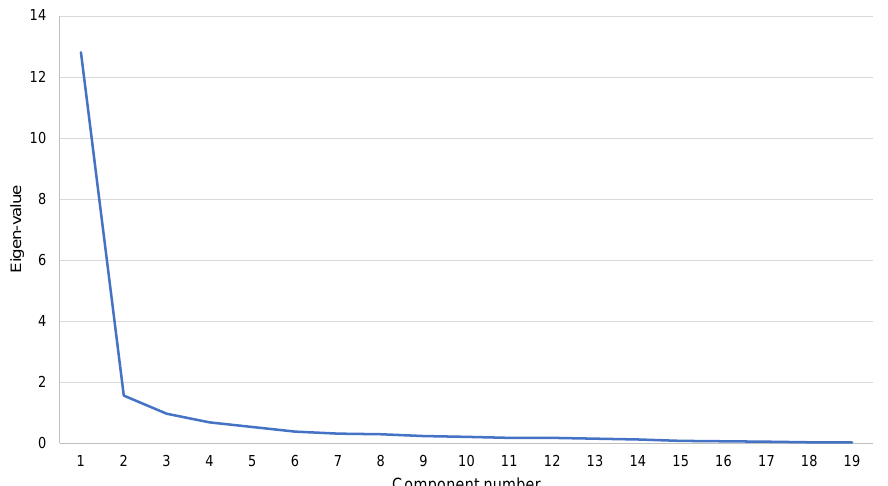
Figure 2. Scree plot of the eigenvalues of the factors for the Galician version of the Nurse Prescribing Self-Efficacy Scale (G-NP-SES). The scree plot shows that the eigenvalues of the first three dimensions are greater than 1.